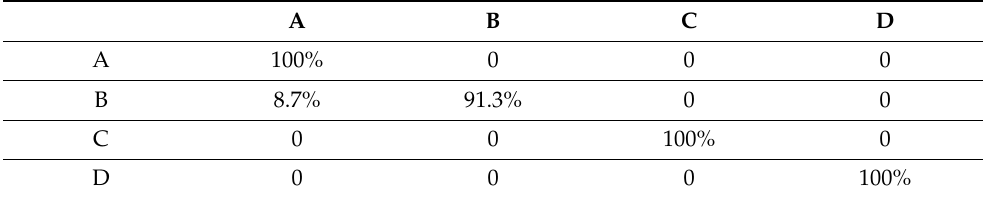
Table 7. Confusion matrix achieved for the Pigmented variety accessions of set 1: A, Sanguinea, B, Red Pulp of Mombuca, C, Sanguinelli and D, Doppio Red Pulp.